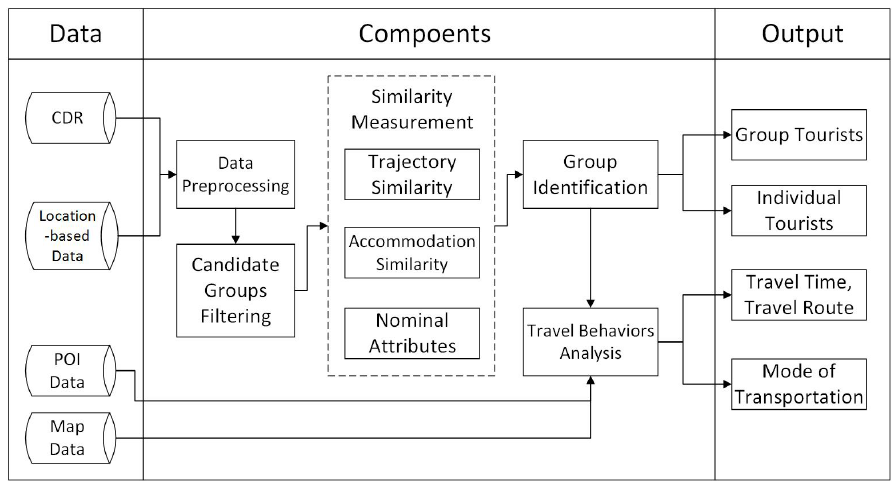
Figure 3. Modeling framework